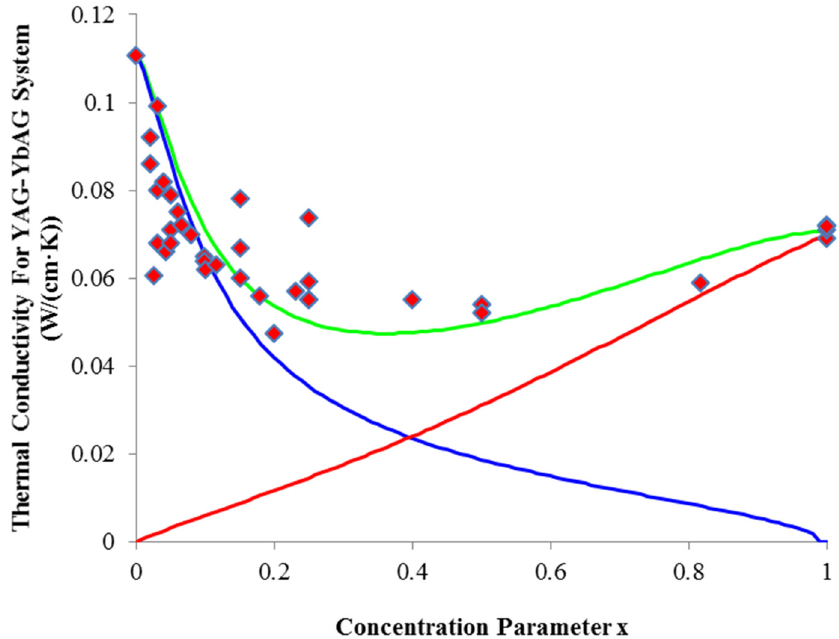
Figure 9. Thermal conductivities k Y (blue), k Yb (red), and k (green) calculated using our model as a function of concentration parameter x for the binary solid solution YAG-YbAG. Data points are taken from the comprehensive summary found in [49]. Constants used in this plot are ξ Y = 300 and ξ Yb = 50.